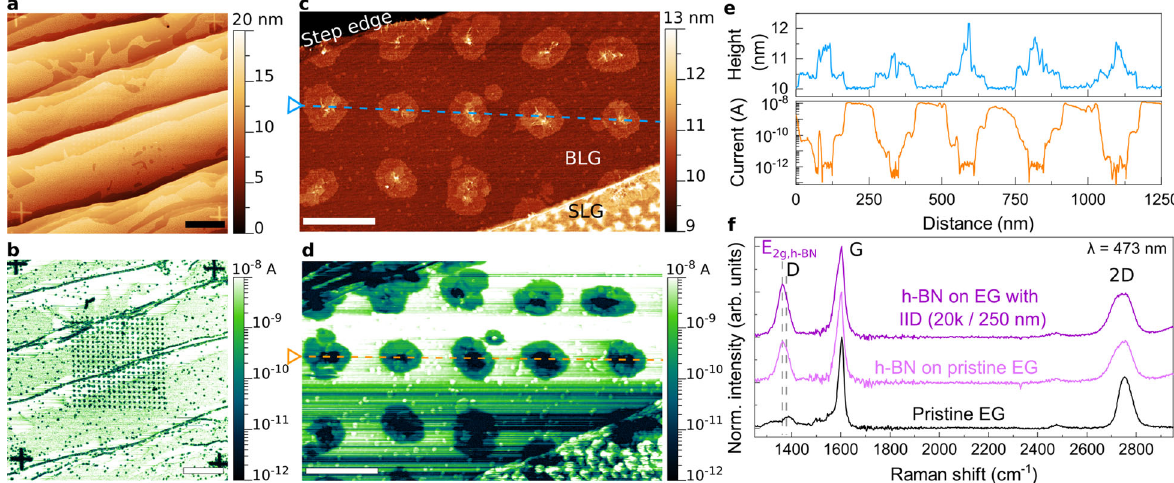
Fig. 2 h-BN islands grown via SAvdWE for 300 min. a AFM image of an area with 19 × 19 defects written with 20,000 ions per IID in a distance of 250 nm to each other between the cross-shaped markers. b Corresponding cAFM image with a bias of 100 mV applied to graphene showing the position of the insulating h-BN islands. c Detailed AFM image of h-BN islands forming close to a step edge on BLG. d Corresponding cAFM image with a sample bias of 200 mV. e Height pro fi le (upper graph) and corresponding current (lower graph) from the blue and orange dotted lines in ( c ) and ( d ), respectively. f Comparison of Raman spectra from pristine graphene with spectra from h-BN islands grown on non-structured areas as well as h-BN islands grown via SAvdWE. The spectra were normalized with regard to the G peak and are vertical shifted for clarity. Scale bars, 2 μ m in ( a ) and ( b ), 250 nm in ( c ) and ( d